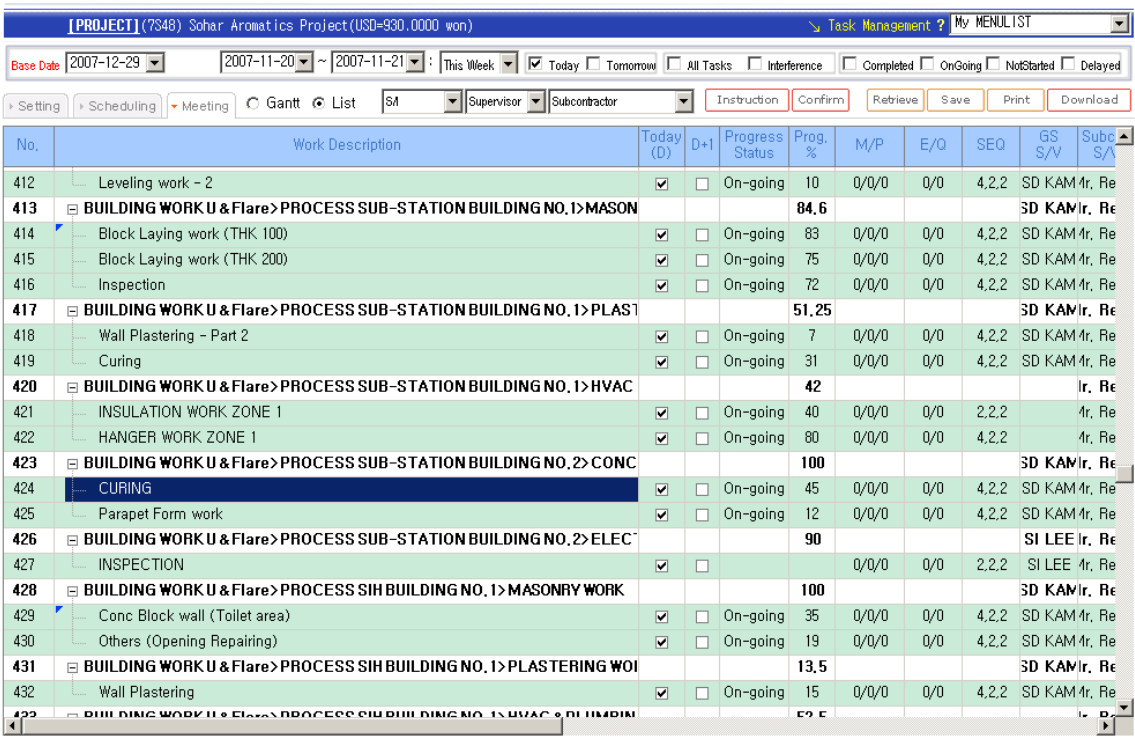
Fig. 16. Confirmation of approved tasks